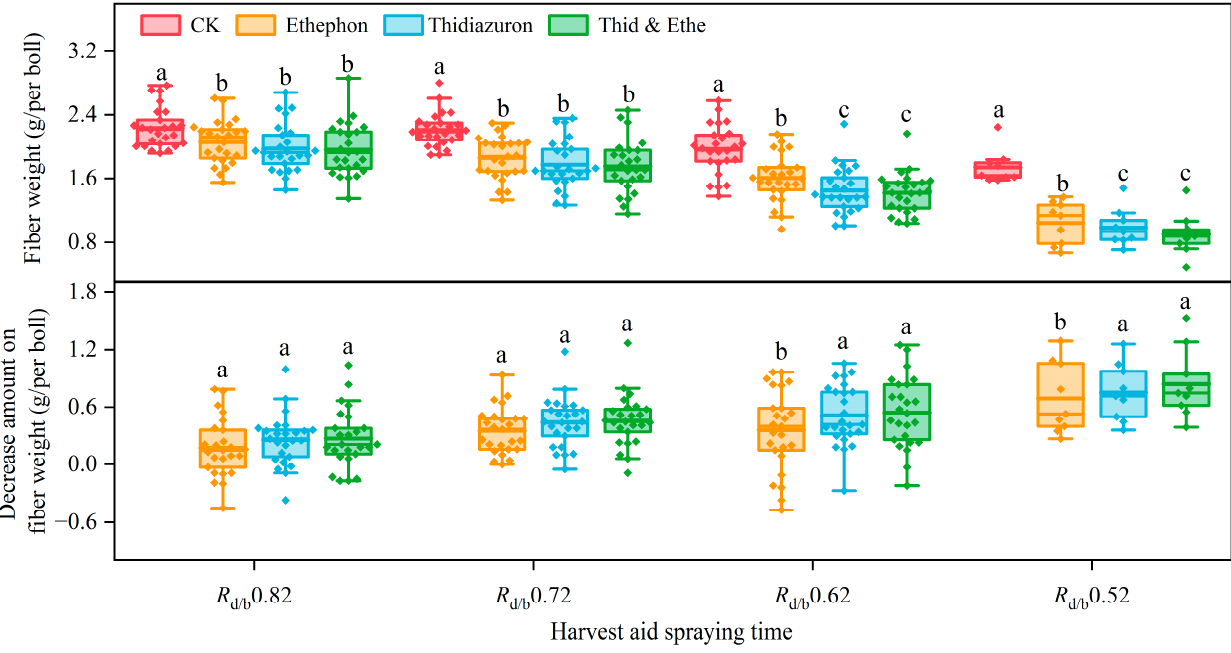
figure indicates the average value. The different letters indicate significant differences between harvest aid